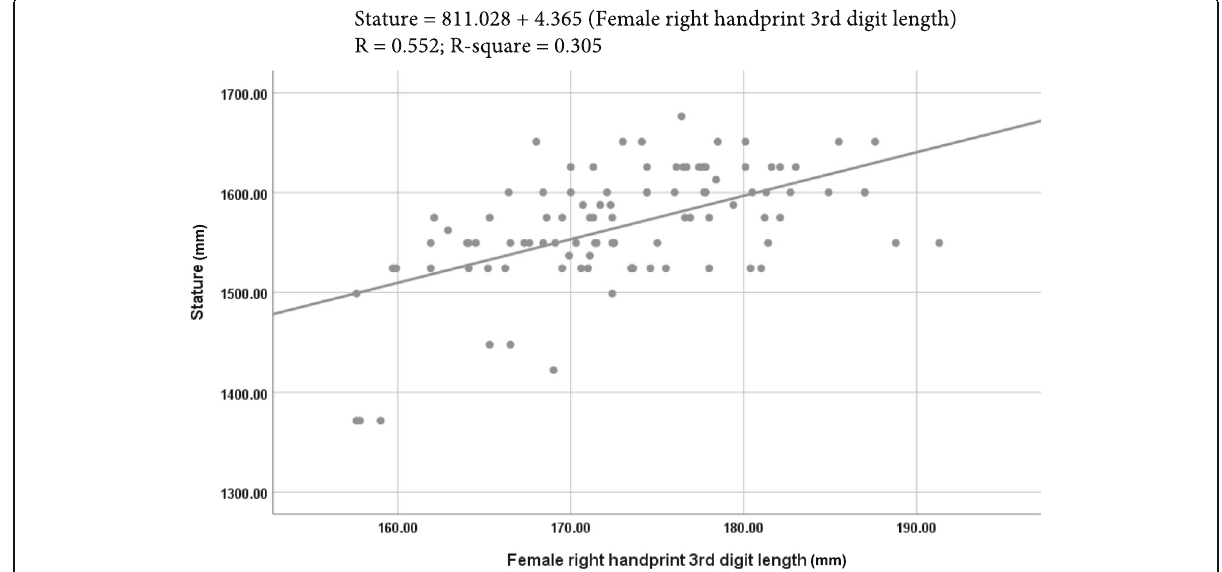
Fig. 4 Best fit curve to estimate stature from female right handprint 3 nd digit